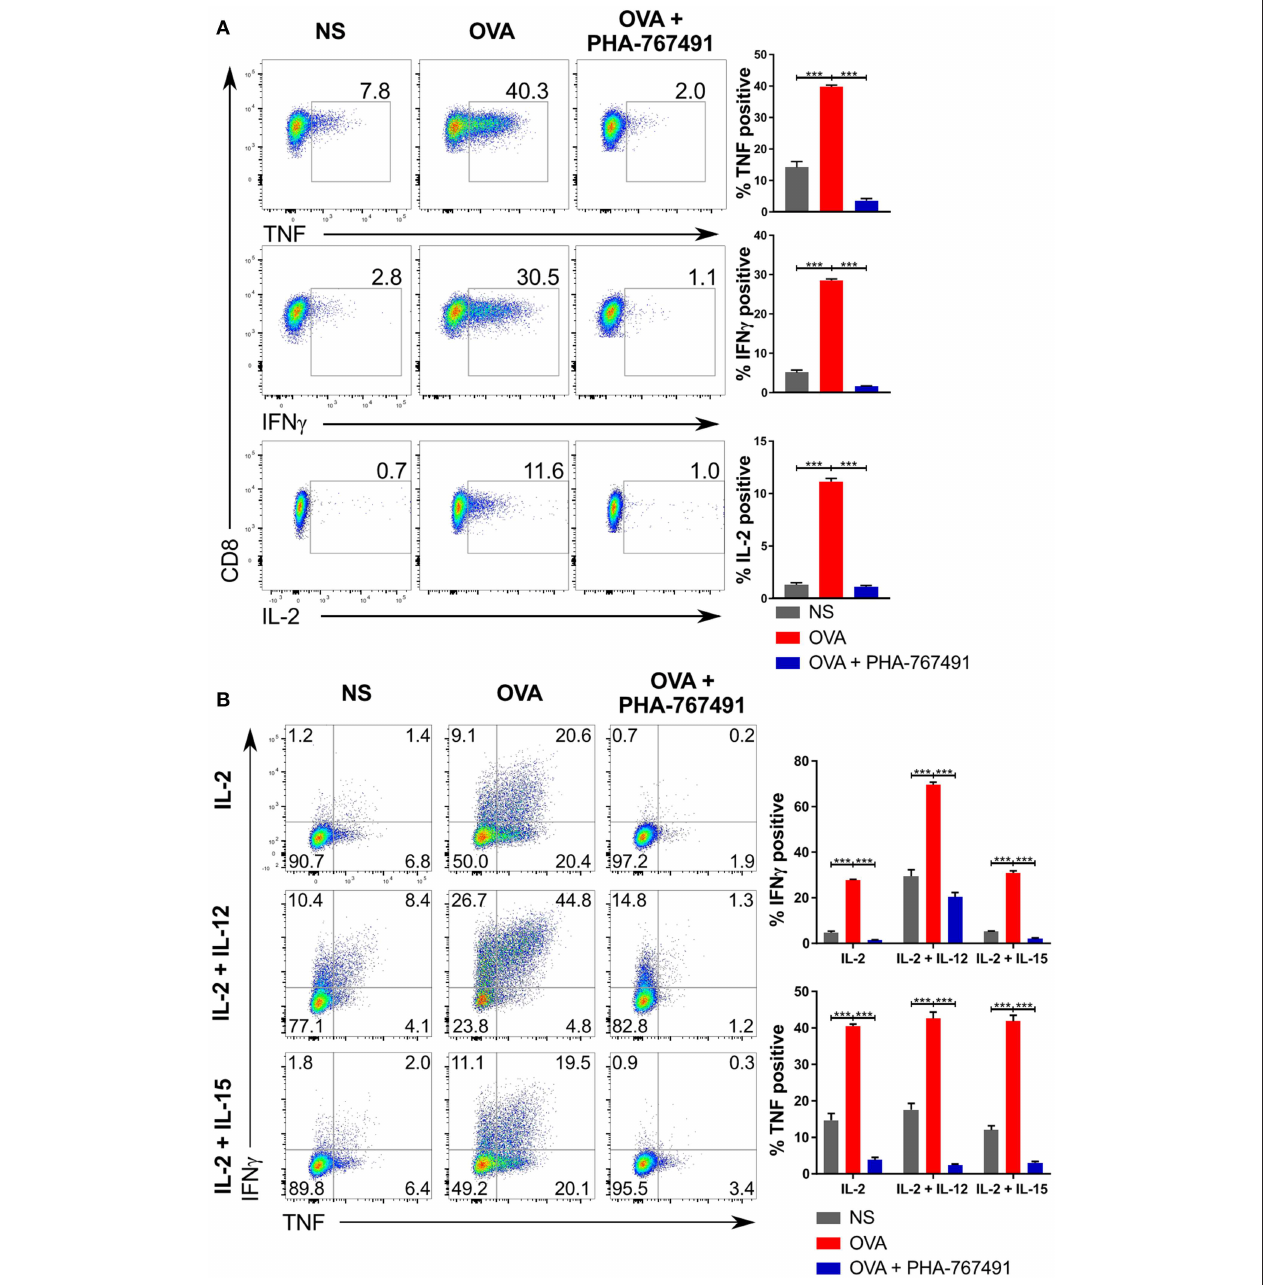
FIGURE 4 | Suppression of cytokine production by PHA-767491. (A) PHA-767491 suppresses cytokine production in OT-I CTL. APCs expressing single chain H-2K b with OVA peptide were seeded into 96 well plates 1 day prior to the experiment. CTL were pre-treated with BFA for 30min before co-culturing with the APCs for 6h. The percentages of the positive population of each sample are indicated for each plot. (B) PHA-767491 also suppresses cytokine production in strongly polarized OT-I CTL. For the preparation of the OT-I CTL, OT-I splenocytes were pre-treated with either 10nM OVA peptide and 10 U/ml IL-2 only, 10nM OVA peptide and 10 U/ml IL-2 with 10ng/ml IL-12, or 10nM OVA peptide and 10 U/ml IL-2 with 10ng/ml IL-15. CTL were pre-treated with BFA and restimulated by co-culturing with APCs expressing single chain H-2K b with OVA peptide for 6h. The percentages of each quadrant in each graph are shown. Data shown is representative of at least three independent experiments. Bar charts are represented as mean ± SEM. Statistical significance was determined by unpaired two-sided Student’s t -test (*** p < 0.001).